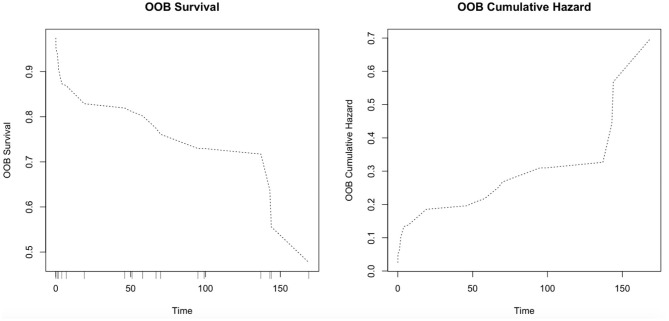
Predicted OOB survival (Left) and cumulative hazard (Right) curves generated from the RSF model to predict VT/VF post-diagnosis.